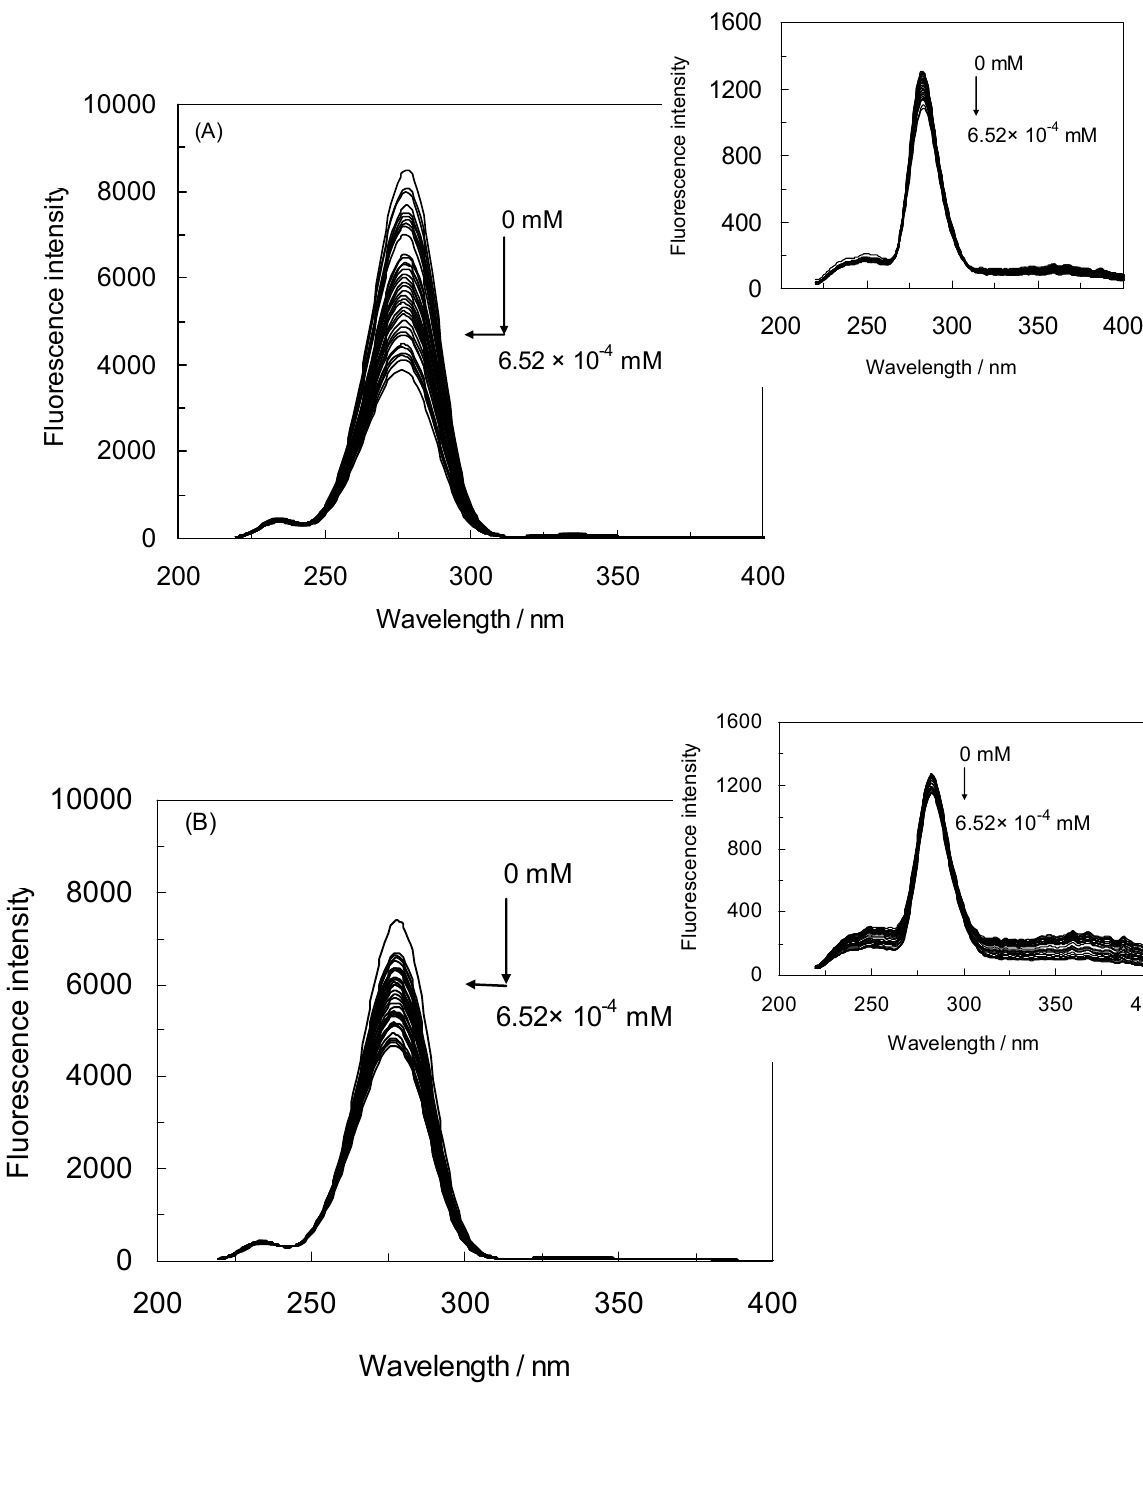
Figure 4. The synchronous fluorescence spectroscopy of HSA-NRF in the absence and presence of EMF, T = 298 K; pH 7.40. ( A ) The HSA-NRF system in the absence of an EMF for Δλ = 60; (inset) Δλ = 15; ( B ) the HSA-NRF system in the presence of an EMF at 100 Hz/2.4 mT Δλ = 60; (inset) Δλ = 15; ( C ) the HSA-NRF system in the presence of an EMF at 100 Hz/6.4 mT Δλ = 60; (inset) Δλ =